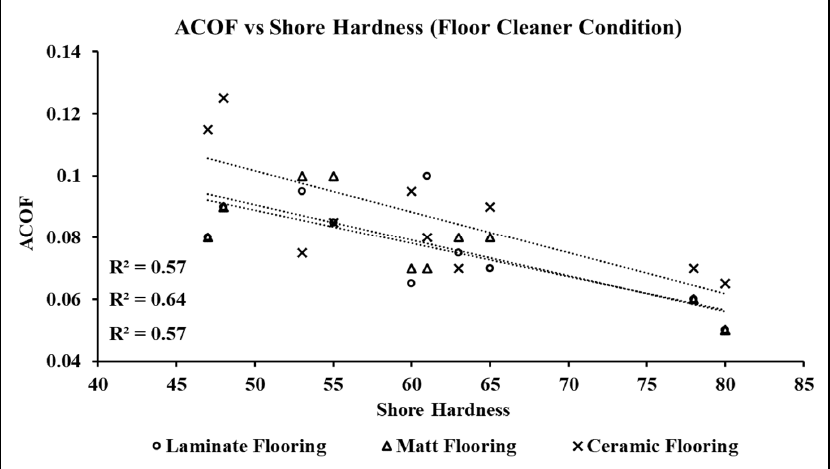
Figure 12. Correlation between shore hardness and ACOF across the shoes in the floor cleaner con ‐ taminant condition.